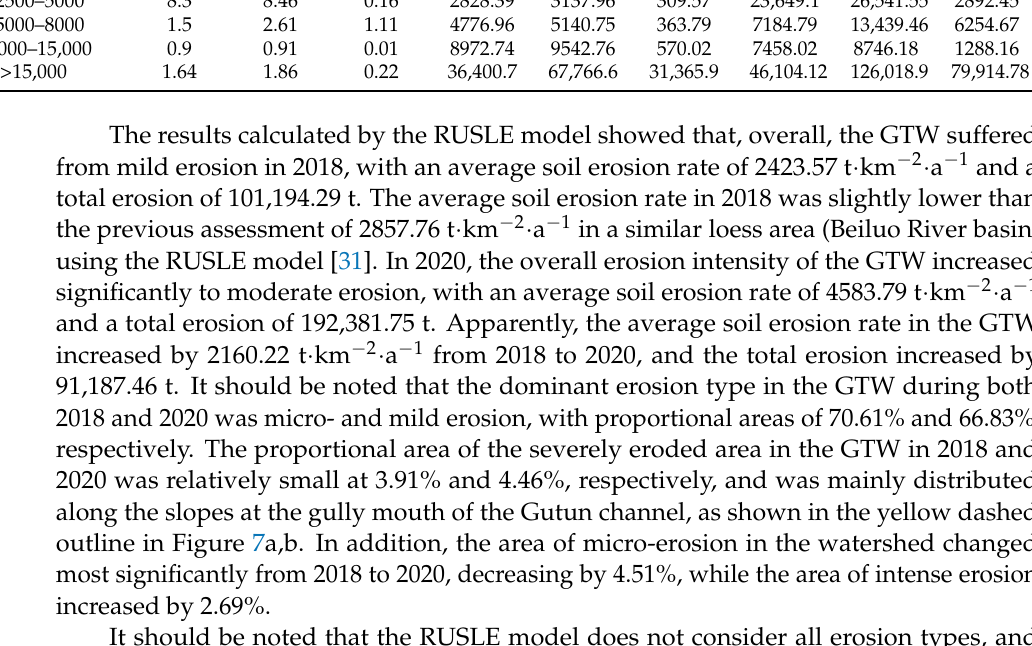
Table 3. Classification statistics of soil erosion intensity in the GTW in 2018 and 2020. Erosion Classification